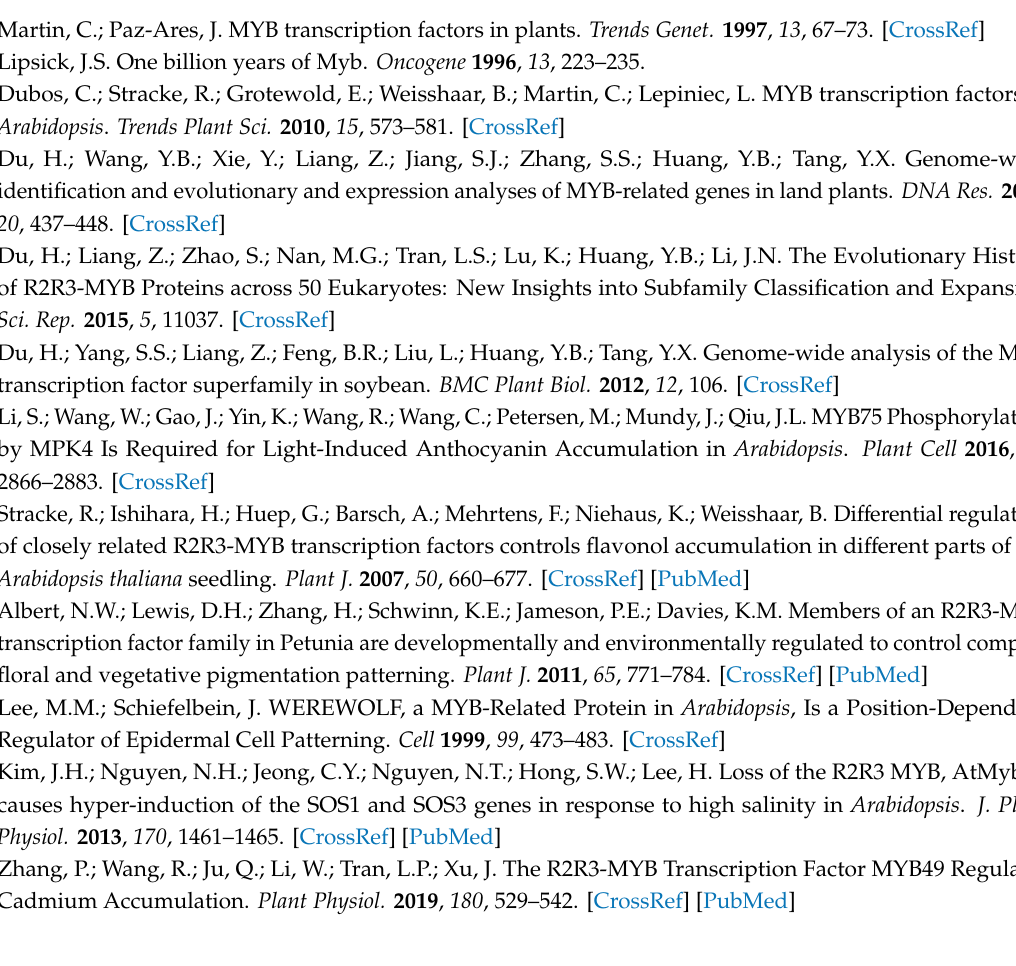
Figure S1: Phylogenetic tree of the R2R3-MYB proteins (2R-MYBs) in Brassica napus and Arabidopsis thaliana ; Figure S2: Phylogenetic tree of the MYB-related proteins (MYBRs) from Brassica napus and Arabidopsis thaliana ; Figure S3: Phylogenetic tree of 2429 plant 2R-MYB proteins from 16 plant species; Figure S4: Physical positions and duplications of 429 Bn2R-MYB and 227 BnMYBR genes in 19 Brassica napus chromosomes; Table S1: Primers used in this study; Table S2: The MYB genes identified the Brassica napus genome; Table S3: The 2R-MYB genes identified in 15 plant species (excepting Brassica napus ) used in this study; Table S4: Duplications of the MYB genes in the Brassica napus , B. rapa , and B. oleracea genomes; Table S5: Expression value (FPKM) of the Brassica napus MYB genes under five hormone treatments in